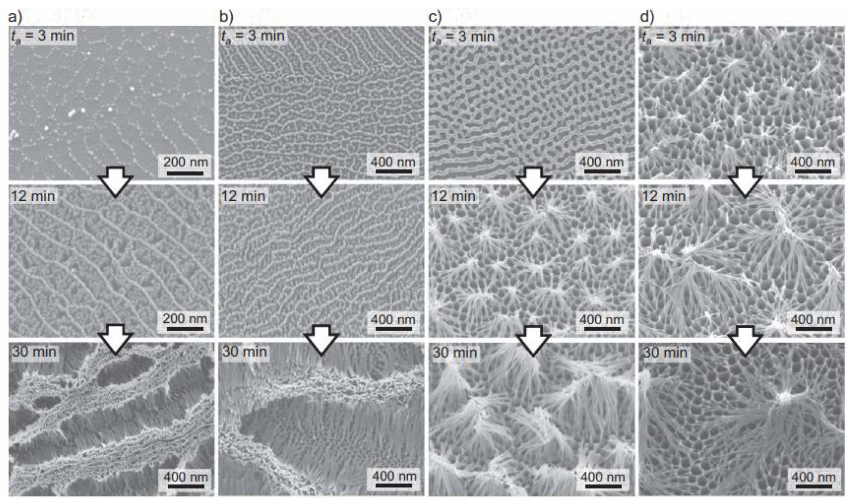
Figure 16. SEM images of aluminum specimens anodized in pyrophosphate solution (293K) at different voltages. ( a ) 10 V. ( b ) 25V. ( c ) 50 V. ( d ) 75V. Reprinted with permission from Ref [74]. Copyright 2018